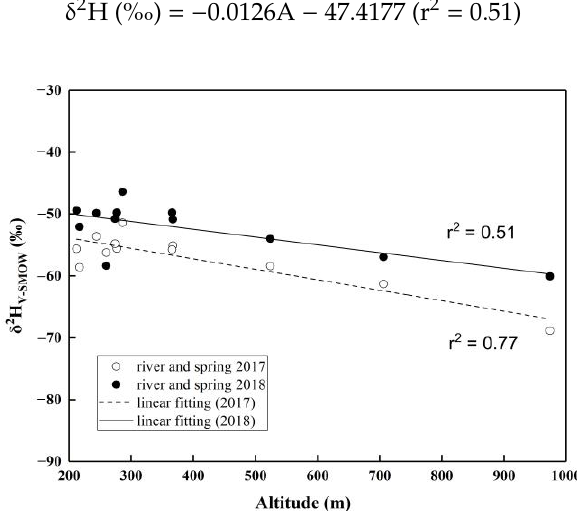
Figure 6. Correlation between δ 2 H and altitude (above 200 m) of river water and spring water.